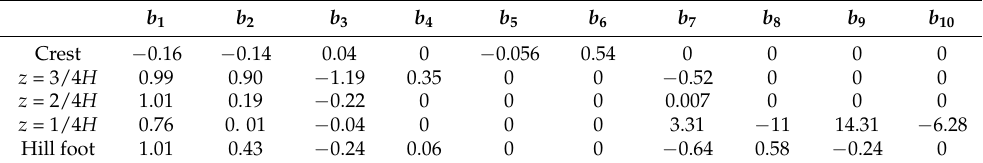
Table 6. Values of b i.